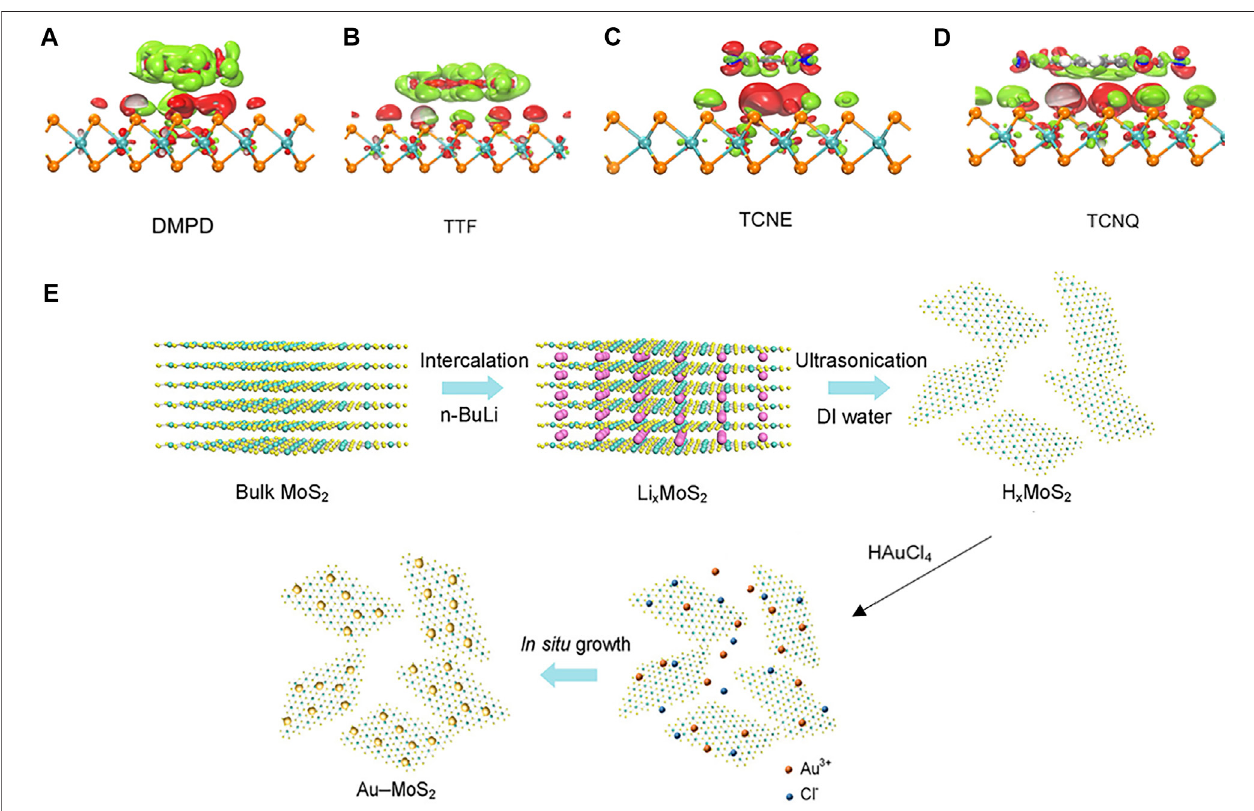
FIGURE3| Thesideviewsofchargetransferbetweenthemolecular acceptors/donorsandMoS 2 . (A,B) aremolecular donorsDMPDand TTF,respectively. (C,D) are molecular acceptors TCNE and TCNQ, respectively. The isosurface at value of 0.002 Å -3 of differential charge density is plotted. The green (red) denotes depletion (accumulation)ofelectrons.ReprintedwithpermissionfromRef.[59],Copyright2016,AmericanChemicalSociety. (E) TheAu-MoS 2 hybridnanomaterialsareformedby growing Au nanoparticles on 2D MoS 2 . Reprinted with permission from Ref. [68], Copyright 2018, American Chemical